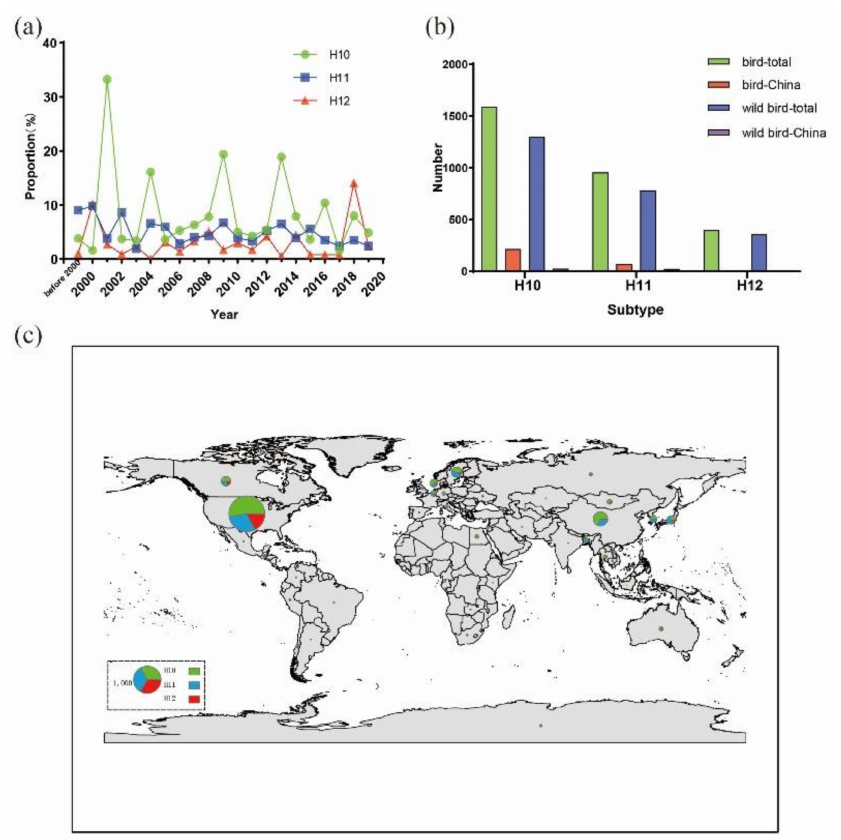
Figure 1. Distribution and yearly number of H10–H12 isolates. Data were obtained from the GenBank (http: // www.ncbi.nlm.nih.gov) and the Global Initiative on Sharing Avian Influenza Data (www.gisaid.org) up to September 10, 2020. ( a ) Percentages of H10–H12 isolates out of the total number of AIVs per year; ( b ) total number of H10–H12 isolates from domestic and wild birds in the world and China; ( c ) global distribution of H10–H12 AIVs in wild birds. Map generated using ArcGIS version 10.2 (http: // arcgis.com / ). Size of each circle represents the number of isolates and the legend circle represents 1000 isolates. Green, blue and red colors represent H10, H11 and H12 isolates,